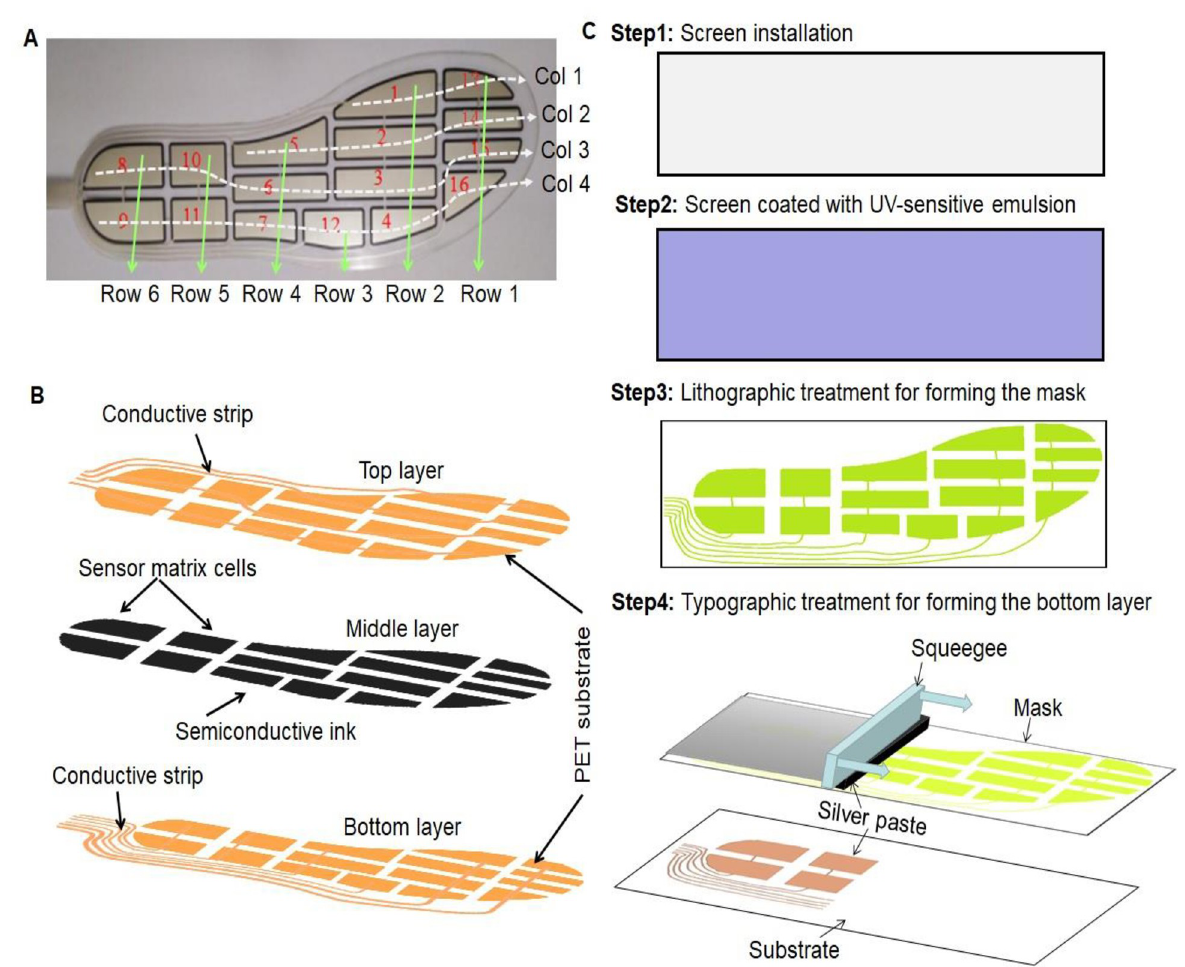
Fig 2. Flexible sensor matrix film with 16 piezoresistive sensors for plantar pressure force measurement, (A) flexible sensor matrix film (col: column), (B) the topologic structure of the flexible sensor matrix film, and (C) fabrication of the flexible sensor matrix film.